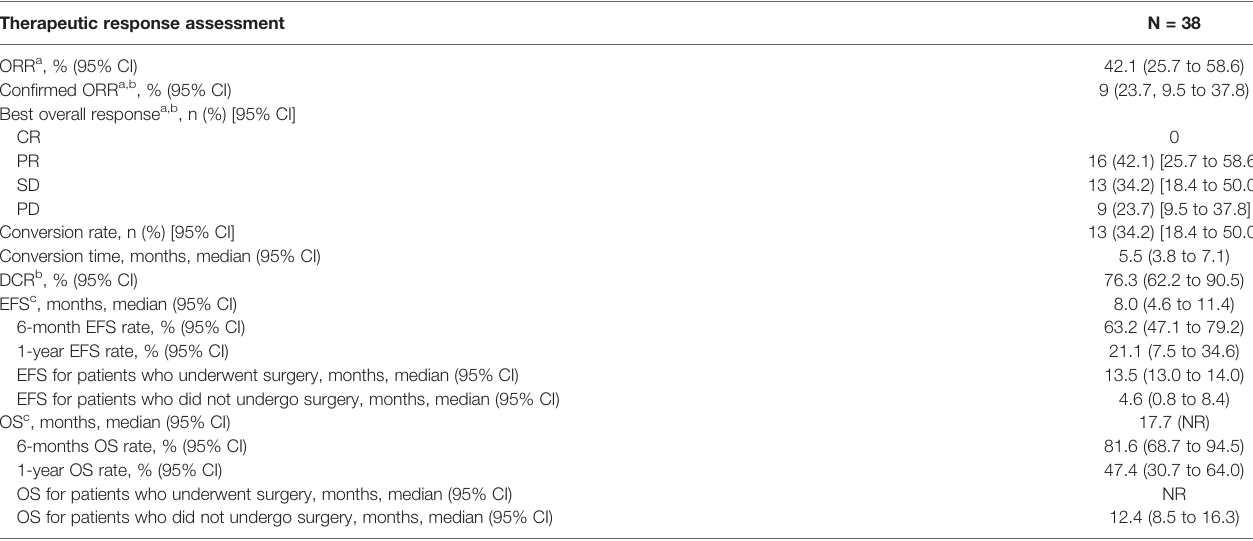
TABLE 2 | Summary of tumor response and survival